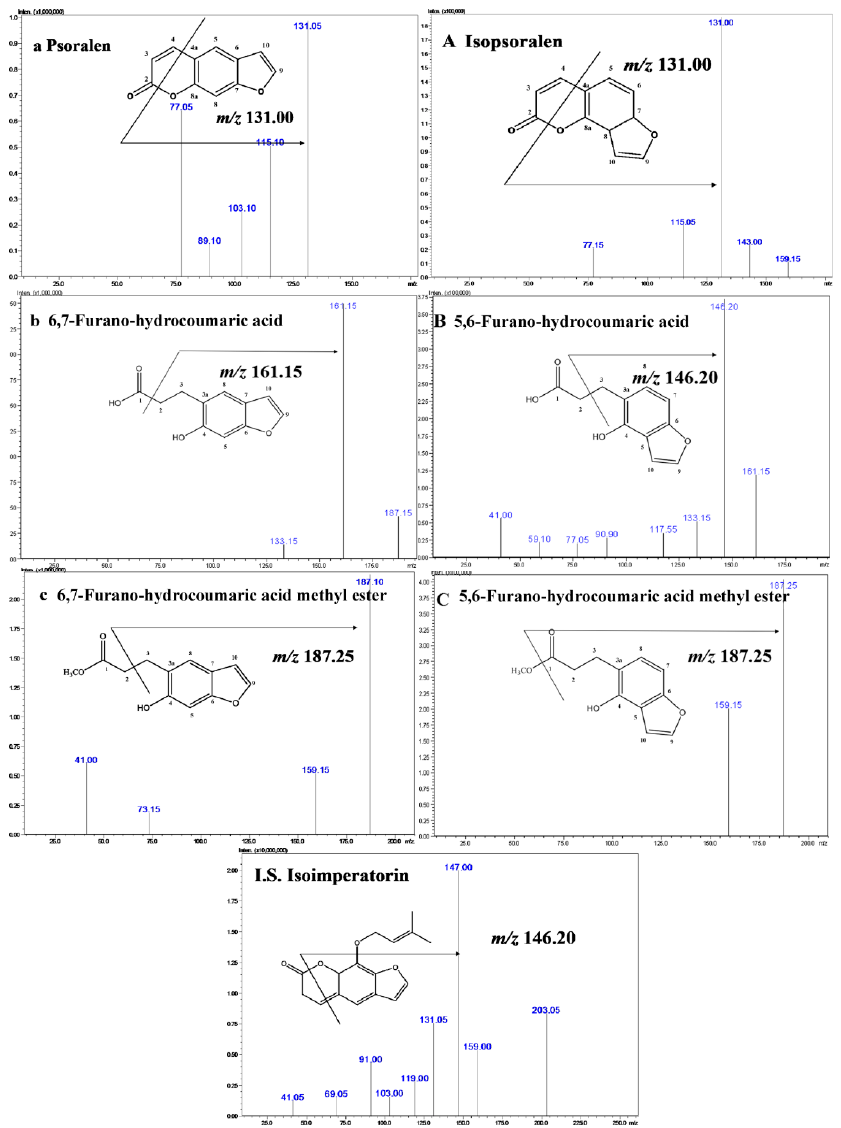
Figure 1. Chemical structures and MS / MS fragmentation patterns of psoralen (P), isopsoralen (IP), and their transformation